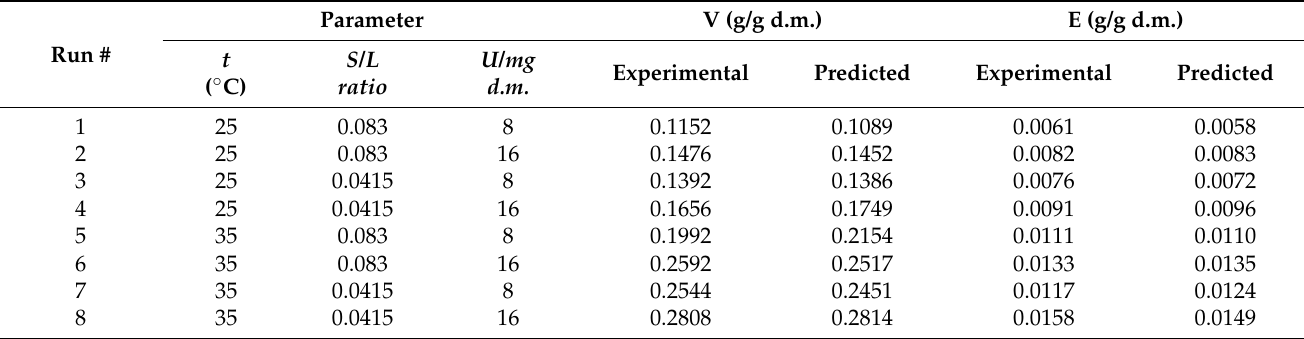
Table 2. Experimental matrix.